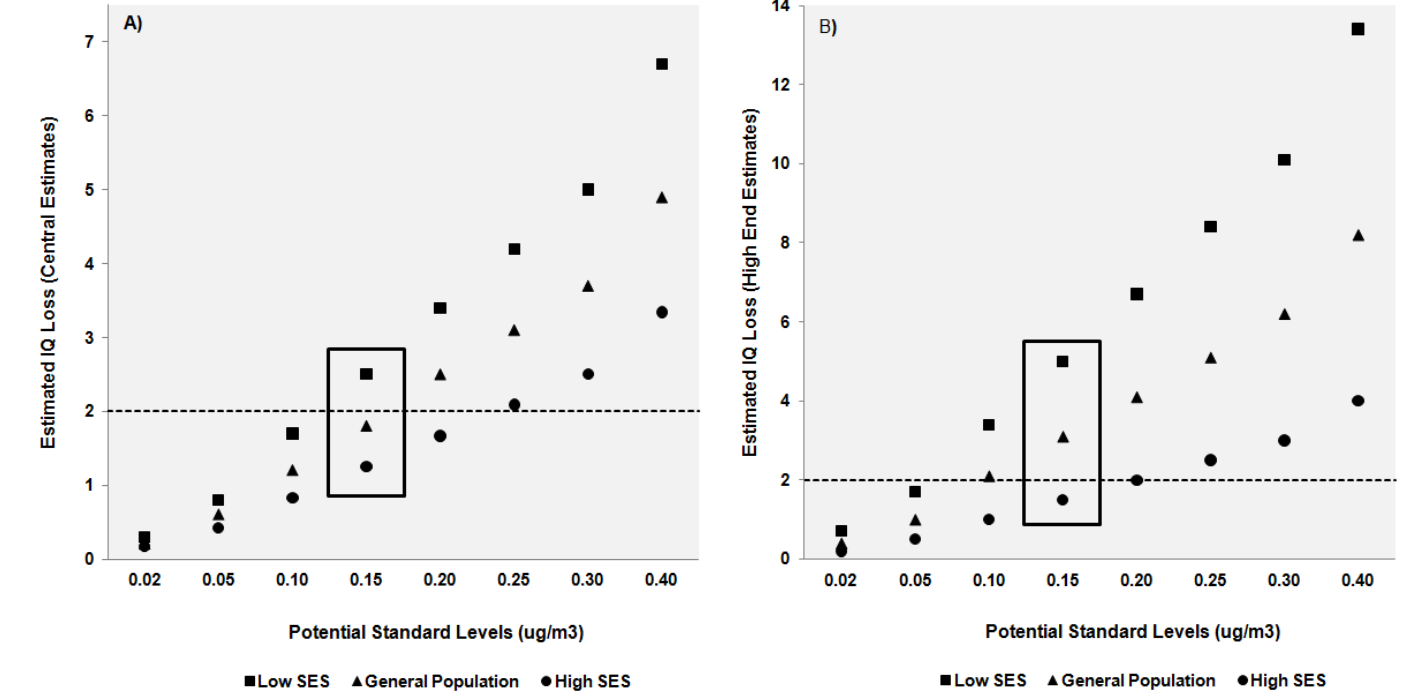
Figure 2. Comparison of IQ loss estimates derived from general population and susceptible groups for two scenarios: ( A ) central estimates derived from median concentration-response (CR) functions; and ( B ) high-end estimates generated from the largest available CR function in each population (see Table 3). Differences across population groups are grouped according to potential standard level. Dotted line at 2 IQ points represents the acceptable risk level defined by EPA. A box surrounds estimates associated with the final